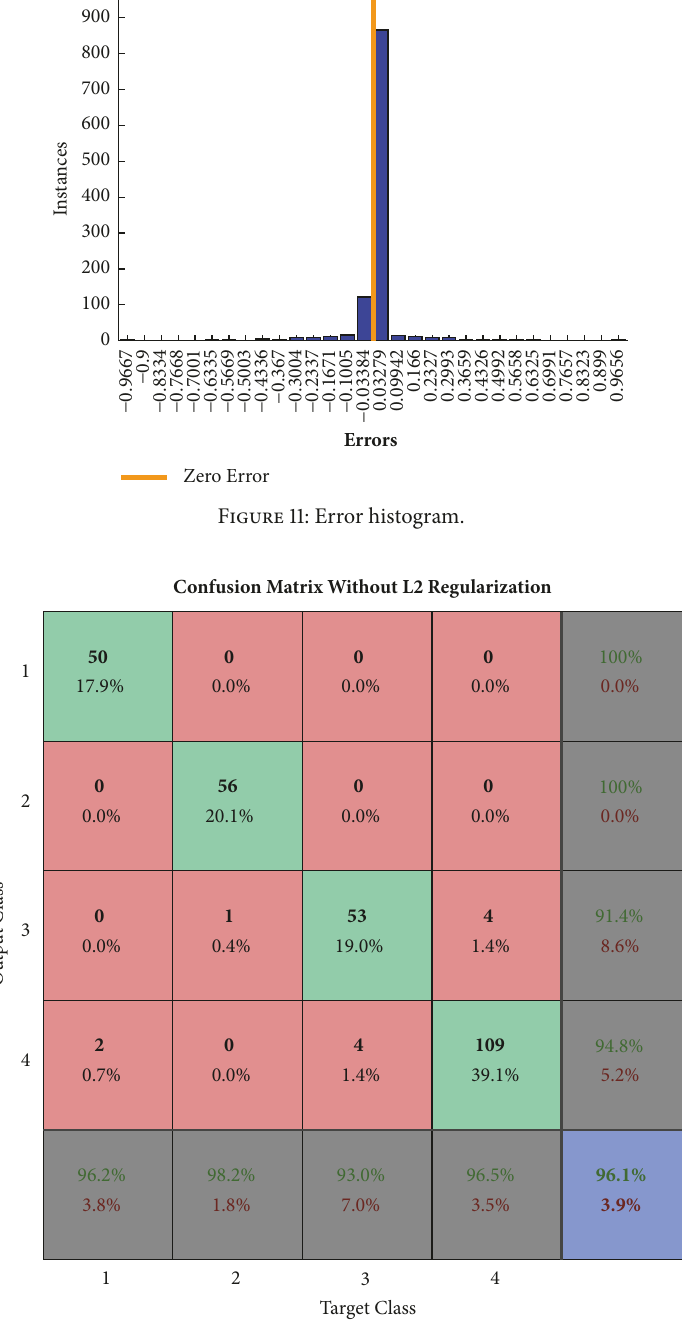
Figure 12: Confusion matrix without L2